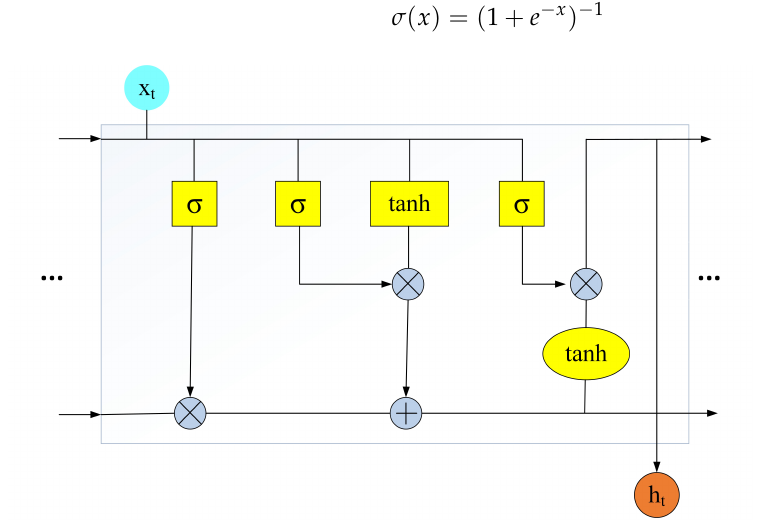
Figure 2. The structure of